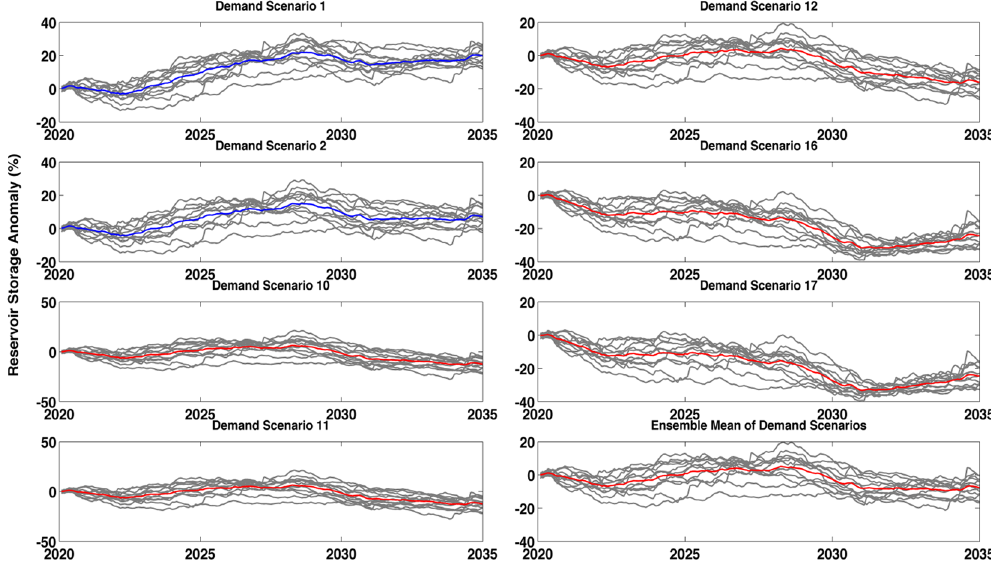
Figure 3. Reservoir water storage anomalies considering future climate and projected demand in 2020–2035 relative to the baseline (1995–2010). Each gray line is a model output driven by one single climate model. A net positive ensemble average (blue) indicates that on average the future storage will be more than the baseline, whereas a negative storage (red) indicates that the system will expect more water stress relative to the baseline (i.e., Millennium Drought) – for demand scenarios see Table S2 in Supplementary